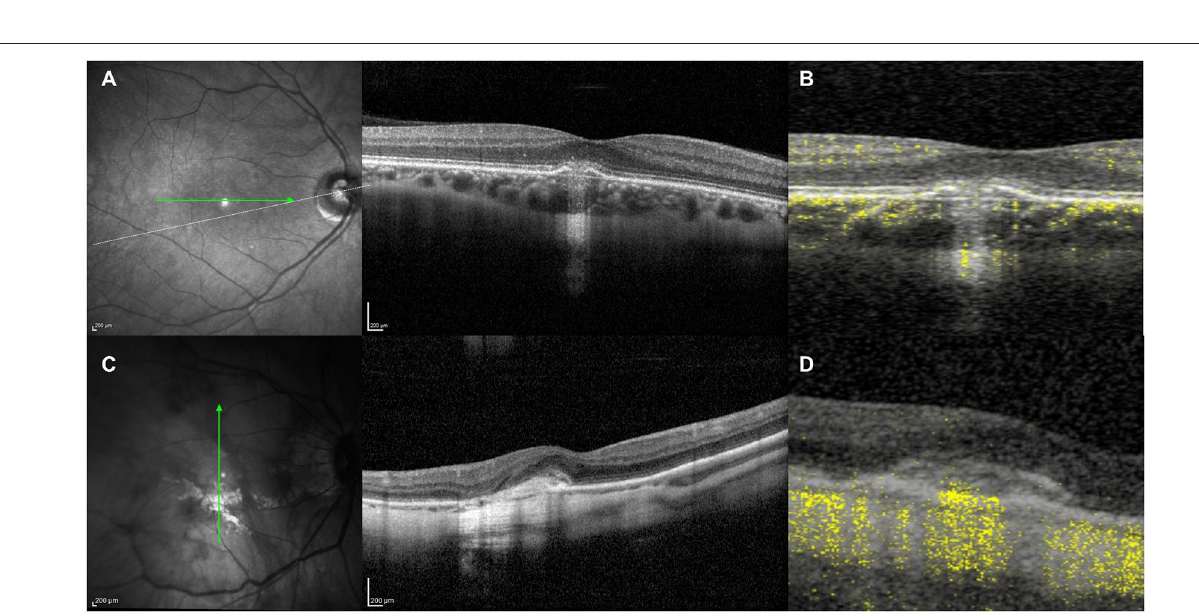
manifestations related to the neovascular process. The general consensus about the protocol to use with anti-VEGF in inflammatory CNV indicates to perform a first intravitreal treatment followed by observation afterwards. The addition of